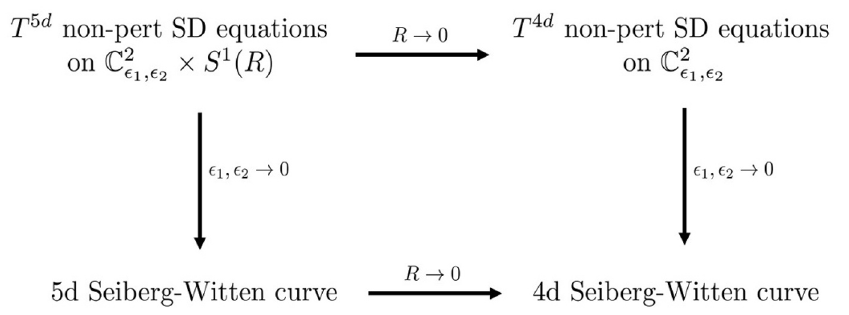
Figure 2 . The various Schwinger-Dyson equations and limits to Seiberg-Witten curves, in 5d and in